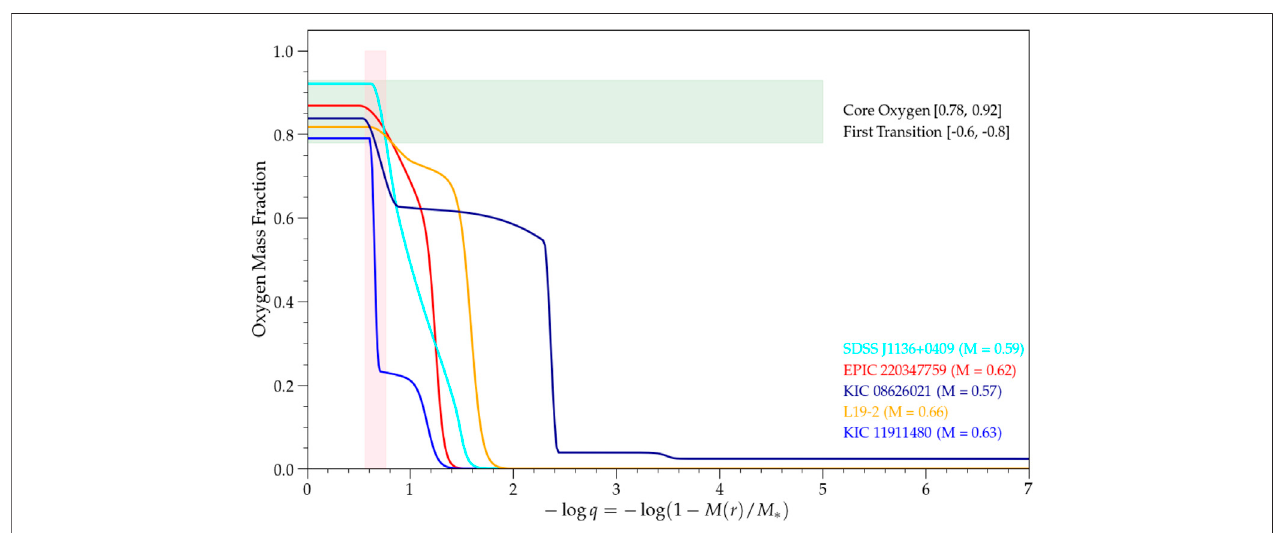
FIGURE 11 | Inferred core oxygen pro fi les for the 4 DAV stars presented in this work, namely: SDSSJ1136 + 0409, EPIC 220347759, KIC11911480, and L19-2, and for the DBV star KIC08626021 (Giammichele et al., 2018).